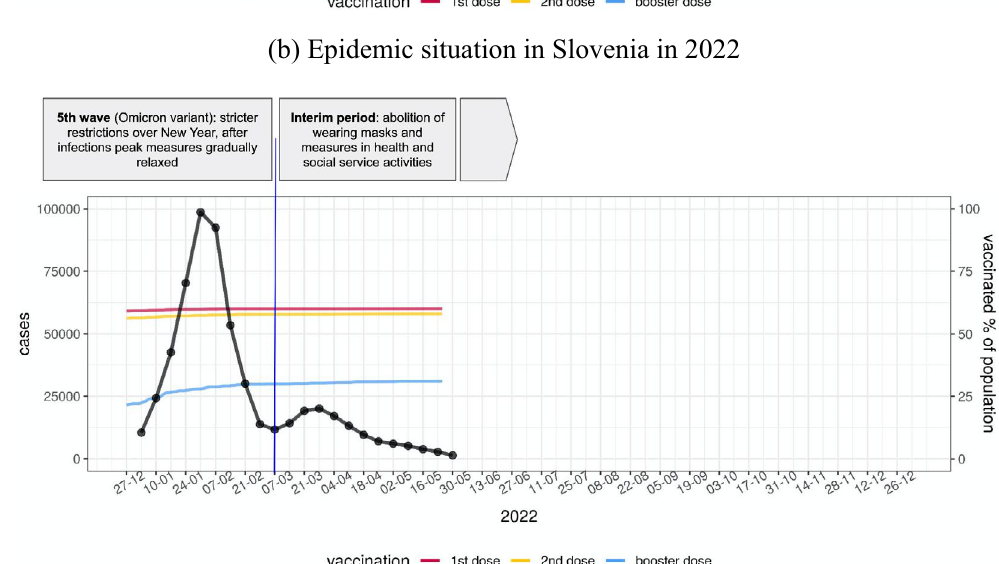
Figure 3. COVID-19 epidemic situation in Slovenia in years 2021 ( a ) and 2022 ( b ). Weekly incidence of confirmed COVID-19 cases (black) and the proportion of population vaccinated against COVID-19 with the first (red), the second (yellow), and the booster dose (blue) 2,19,27,28 are shown. The phases of the epidemic, together with prevailing viral variants and non-pharmaceutical public health interventions, are briefly described in the timeline on